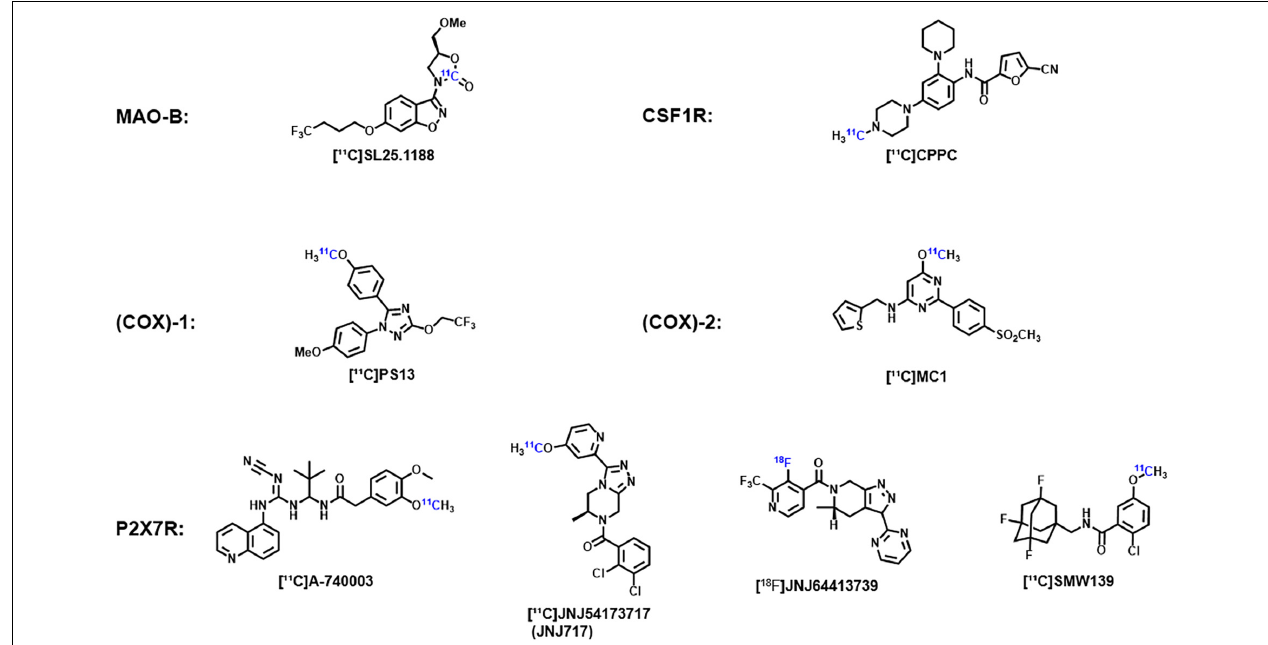
FIGURE 1 | Chemical structures of the corresponding probes of monoamine oxidase B, cyclooxygenase-1, cyclooxygenase-2, colony-stimulating factor 1 receptors, and purinable P2X7 receptors.